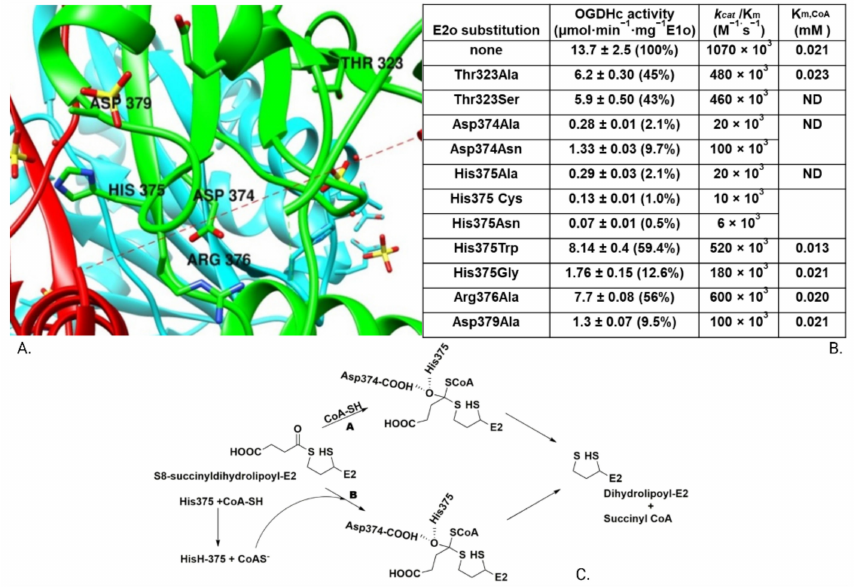
Figure 5. The active center of the E. coli E2o and suggested catalytic mechanism. ( A ) The E2o active center is located between the threefold related subunits shown in red , green and blue . The E2o active center residues of Thr323, Asp374, His375, Arg376 and Asp379 are indicated. ( B ) The effect of substitutions in the E2o active center on the catalytic efficiency of the OGDHc. ( C ) Two mechanisms suggested in pathways ( A ) and ( B ) for succinyl transfer from dihydrolipoamide-E2o to CoASH [106]. Created with